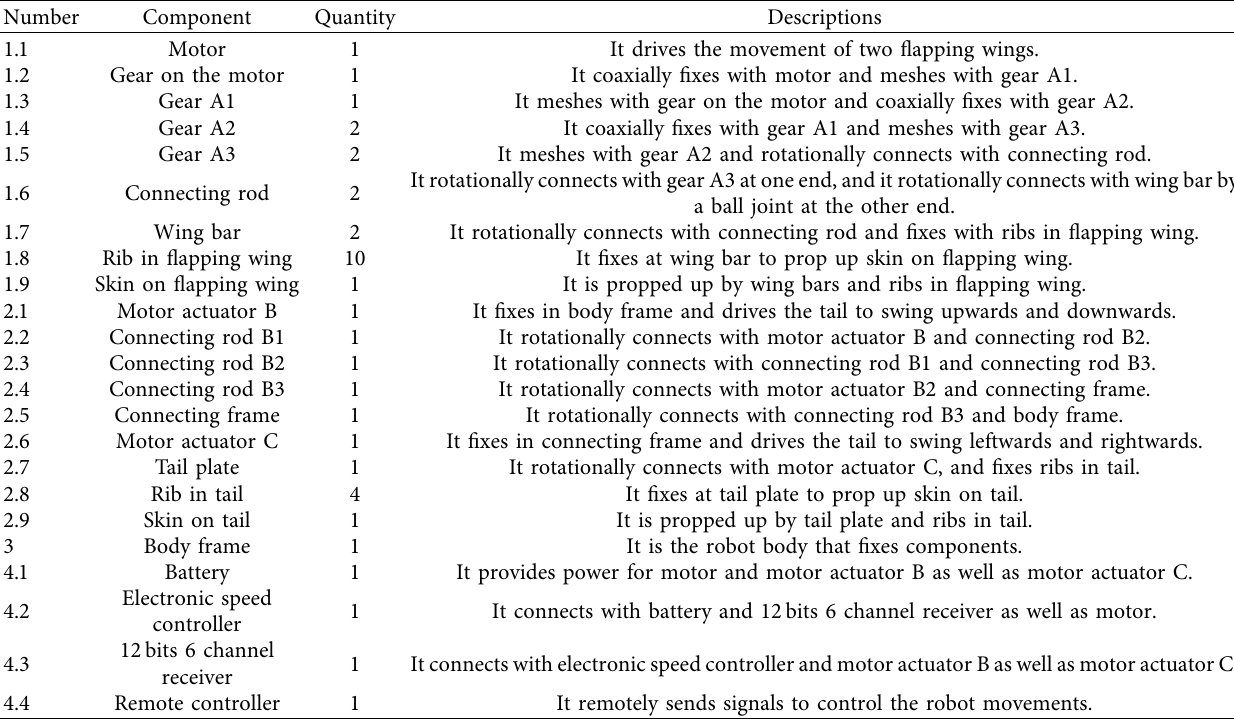
Table 1: The components of the flapping wing robot.